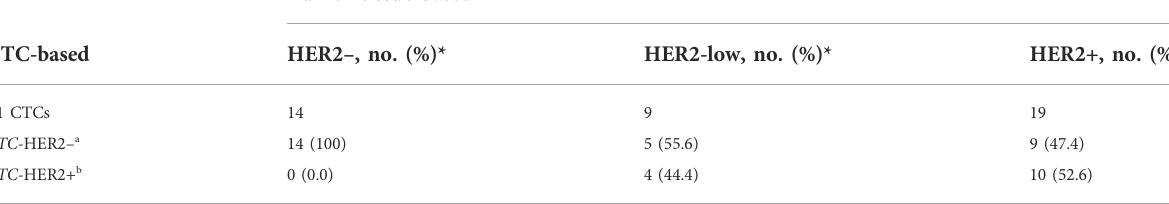
TABLE 2 Comparison of HER2 assessments on CTCs and tumor tissues from breast cancer patients at baseline. Tumor tissue-based CTC-based HER2 – , no.